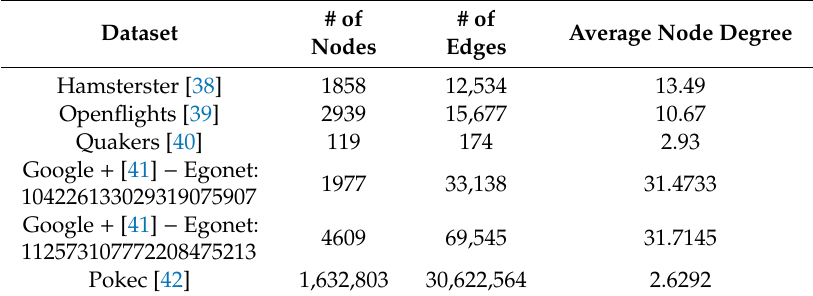
Table 1. Evaluated